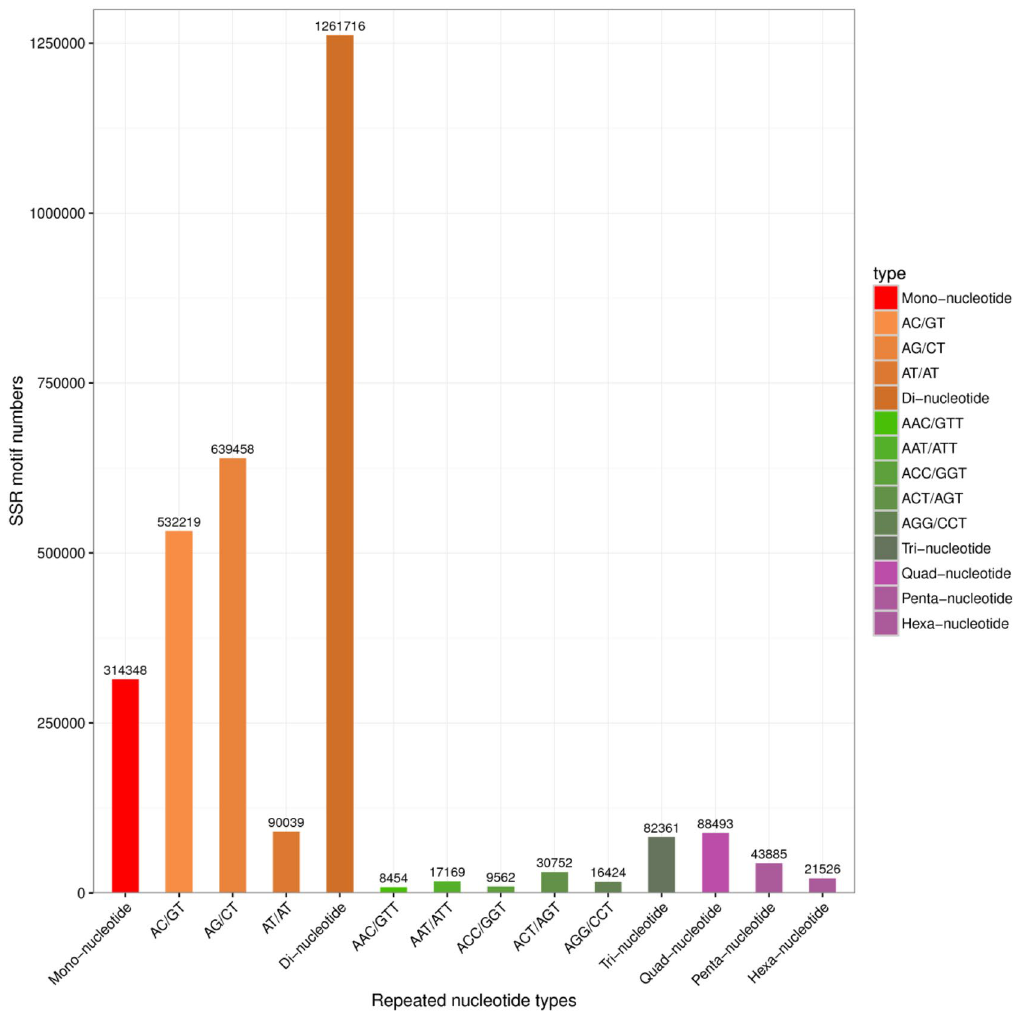
Figure 9. SSR motif repeat distribution in transcriptome data of